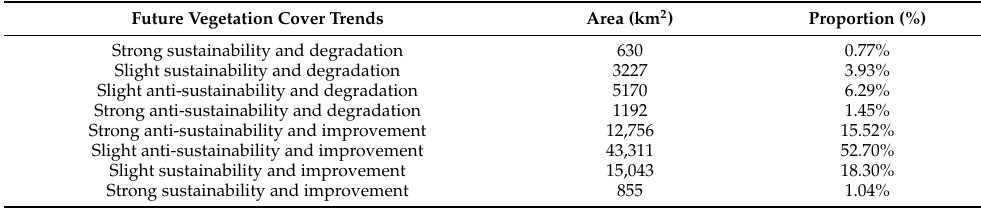
Table 11. Area and proportion of different vegetation-cover change trends in the